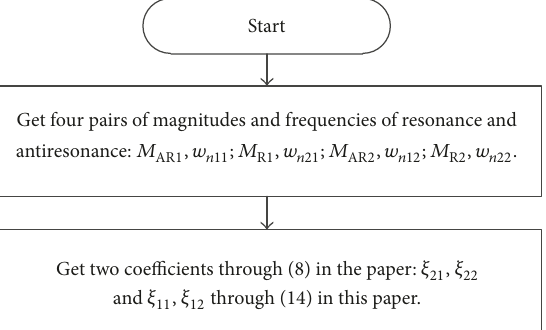
7.131 × 10 13 𝑠 4 + 1.884 × 10 16 𝑠 3 + 9.582 × 10 20 𝑠 2 + 8.715 × 10 22 𝑠 + 1.569 × 10 𝐿 ( 𝑠 ) =